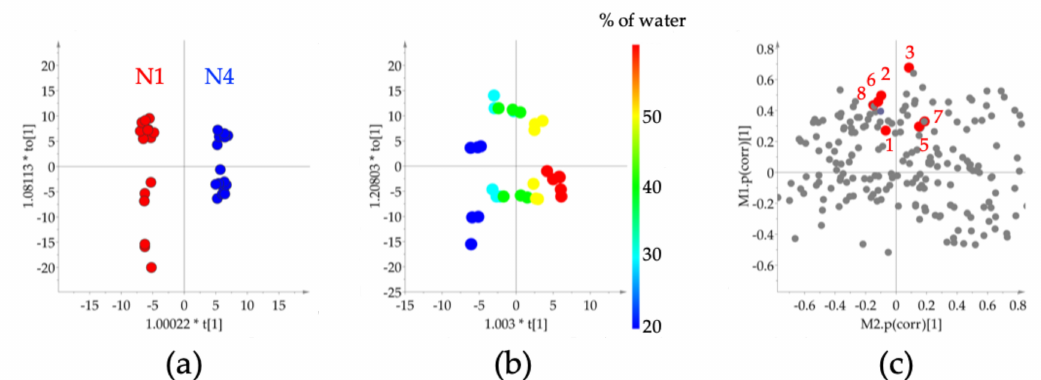
Figure 5. Orthogonal partial least square modeling of HPTLC and HPLC data of Scutellaria baicalensis roots with the kind of NADES (N1 and N4) and the percentage of water added to NADES. ( a ) Score plot of OPLS-DA for the e ff ect of the kind of NADES (N1 and N4), ( b ) Score plot of OPLS for the e ff ect of the percentage of added water, ( c ) SUS plot to combine two models (the kinds of NADES and the percentage of water). N1: citric acid– β -alanine (1:1, mole / mole). N4: citric acid–proline (1:1, mole / mole). Compounds in SUS plot (c): baicalein ( 1 ), scutellarein ( 3 ), wogonin ( 5 ), oroxylin A ( 7 ) and their glycosides, baicalin ( 2 ), wogonoside ( 6 ) and oroxyloside ( 8